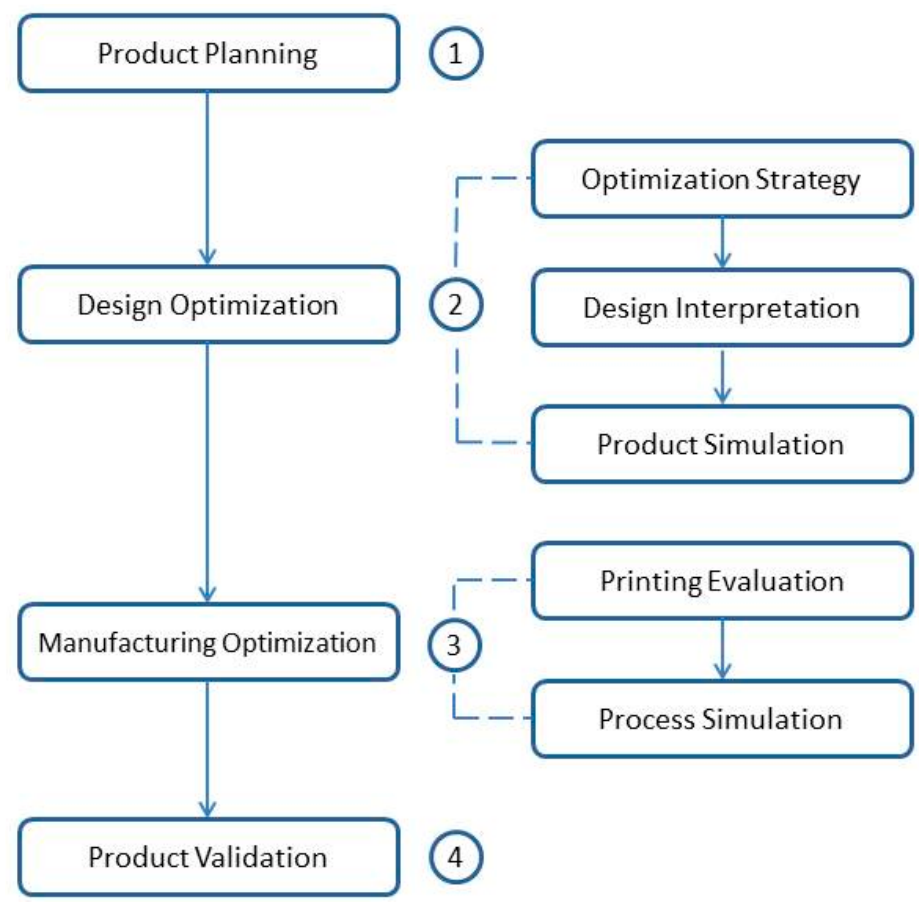
Figure 1. Holistic design workflow for AM.